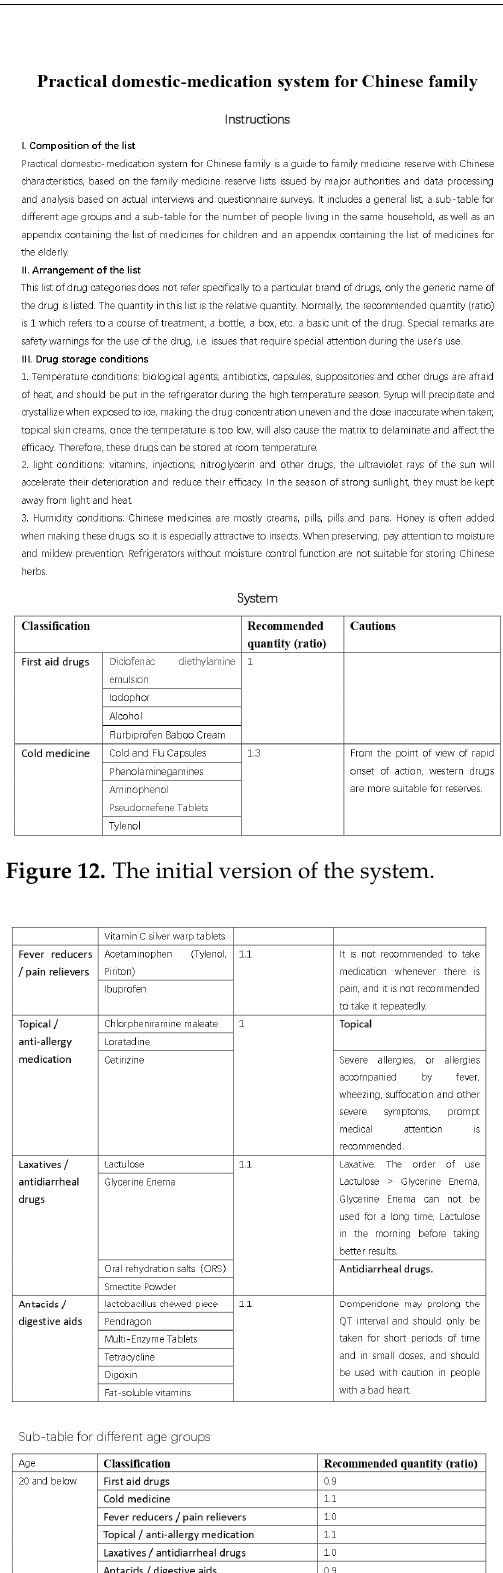
Figure 14. The initial version of the system.